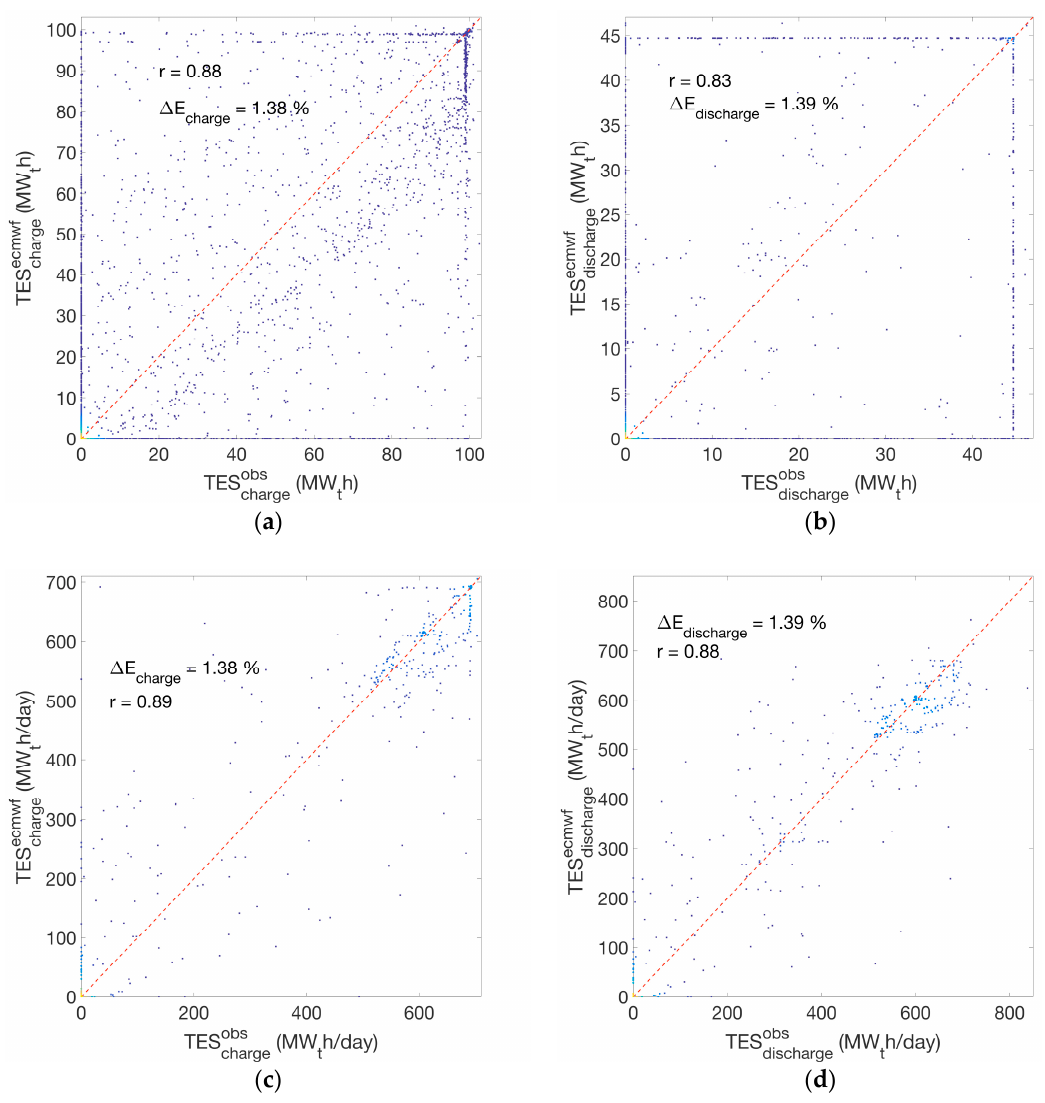
Figure 3 . Estimated hourly values of stored thermal energy into the grid, TES (MW t h)—( a ) charge and ( b ) discharge energies, computed from forecasted (ecmwf) and measured (obs) data at Évora, while corresponding daily values are presented in ( c ) and ( d ). Hourly values of DNI were used in the SAM to simulate the TES from a CR power plant, with a configuration similar to the Gemasolar plant (Sevilla, Spain). Identity lines (red dashed lines), the corresponding correlation coefficients, r, and relative differences, ∆ E, are shown. The period of study corresponded to one year, from 1 July, 2017 to 30 June, 2018.